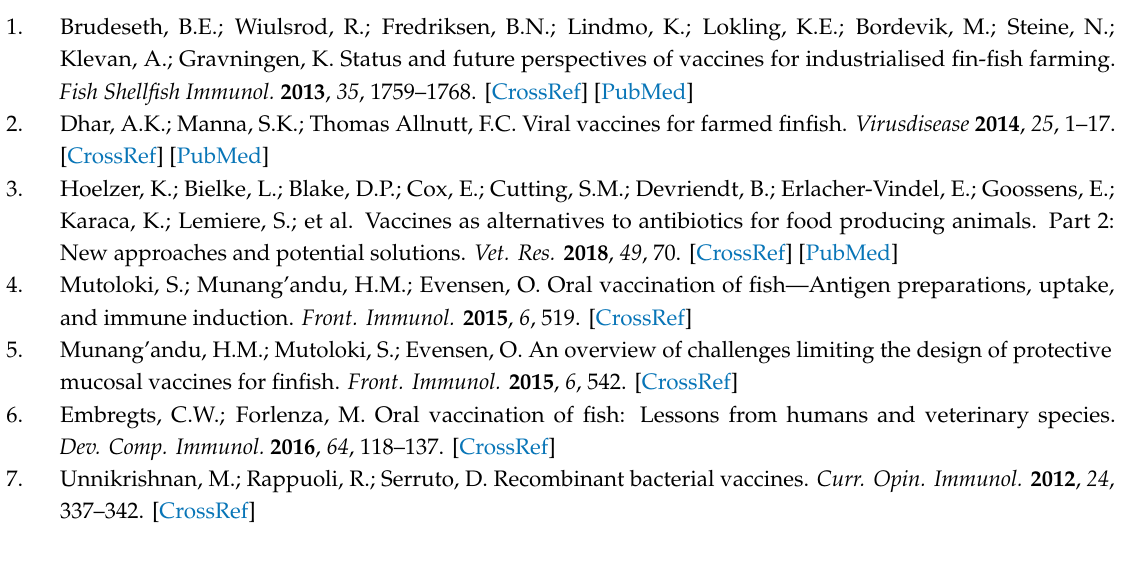
Figure S1: Identification of the recombinant B. subtilis strains by PCR or amylase analysis, Figure S2: Spore germination of the recombinant strains and the wild-type strain 168 on LB plates, Figure S3: Cumulative survival rate of grass carp after GCRV challenge, Table S1: The primers used in this